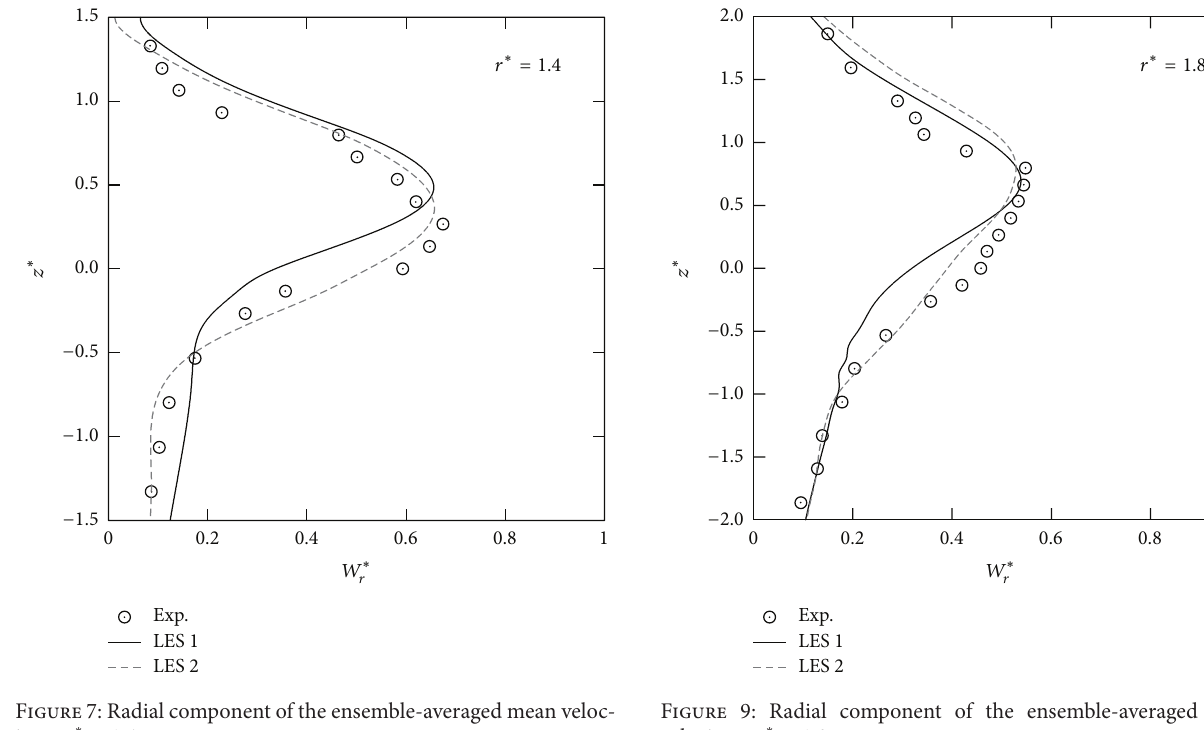
Figure 7: Radial component of the ensemble-averaged mean veloc- ity at 𝑟 ∗ = 1.4 .